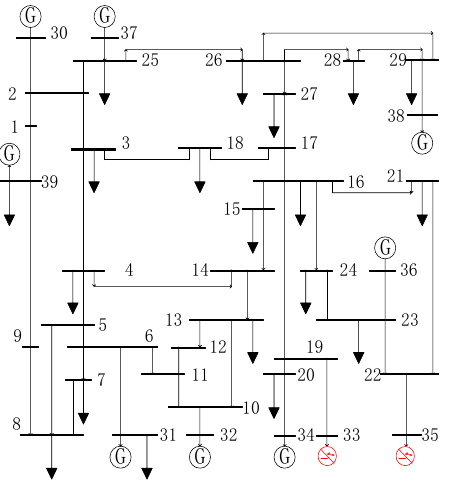
Figure 4. Two-infeed AC/DC New England test system.